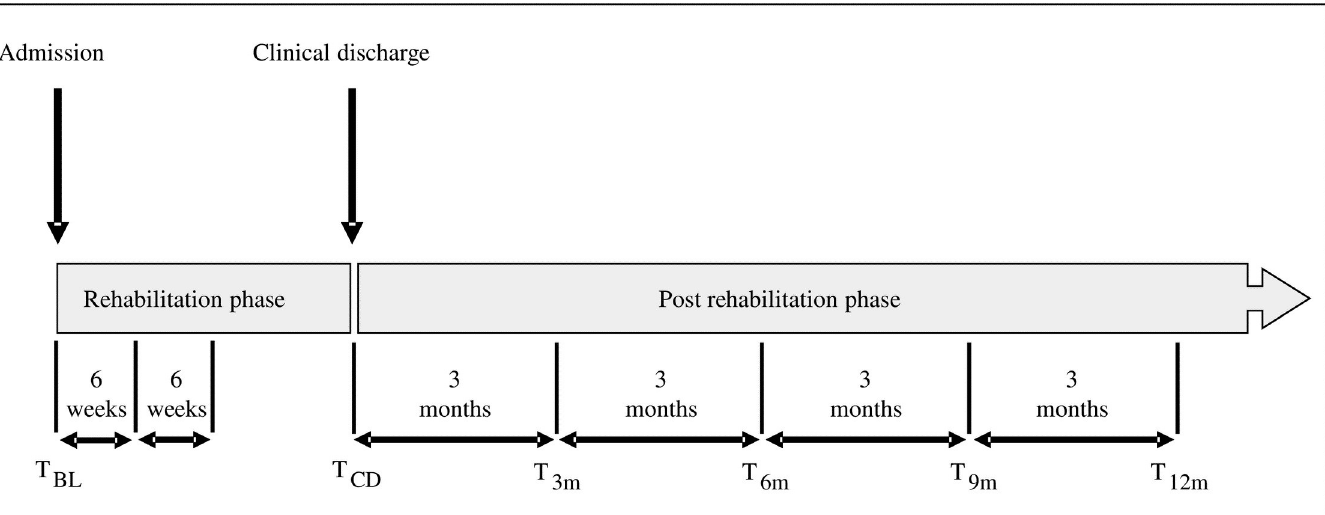
PLOS ONE | https://doi.org/10.1371/journal.pone.0214651 April 1,